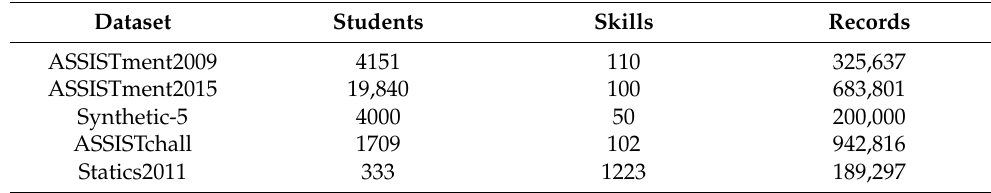
Table 2. Introduction of the